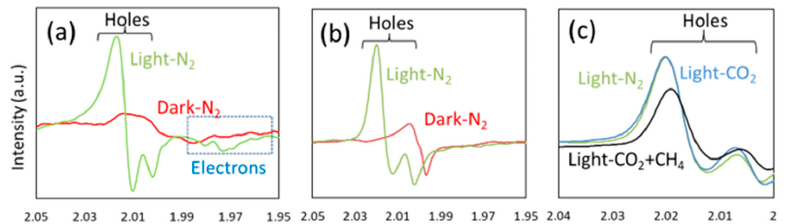
Figure 33. Electron spin resonance (ESR) spectra of ( a ) SrTiO 3 under N 2 ; ( b ) Rh/SrTiO 3 under N 2 ; ( c ) Rh/SrTiO 3 under UV N 2 , CO 2 , and CO 2 + CH 4 . Reprinted from [30].